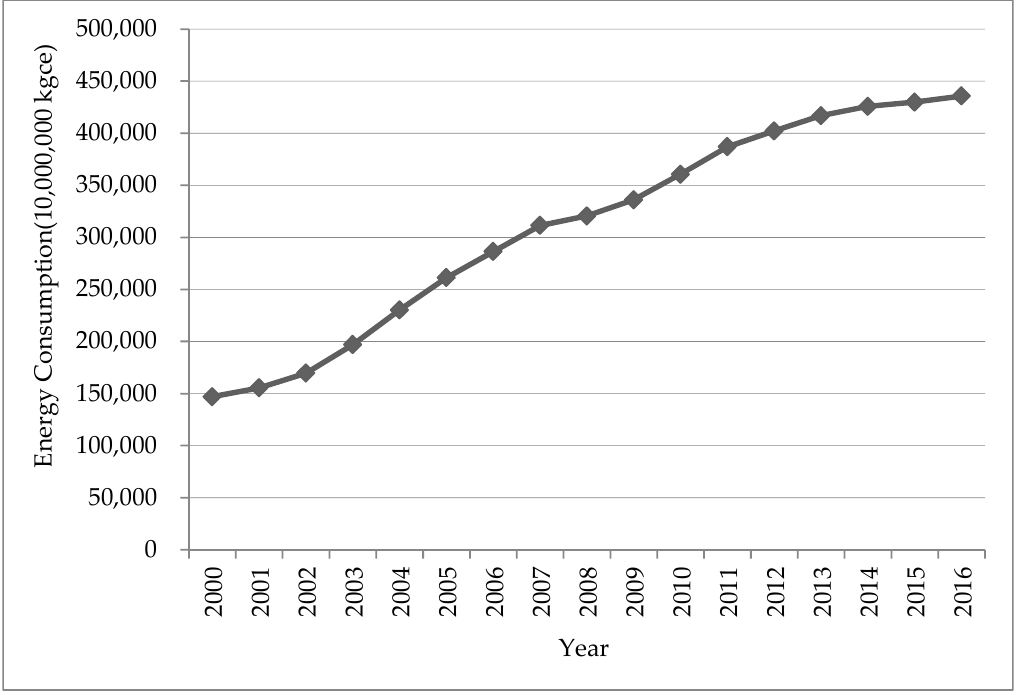
Figure 1. Total energy consumption in Beijing. Source: China Statistics Yearbook (2017).